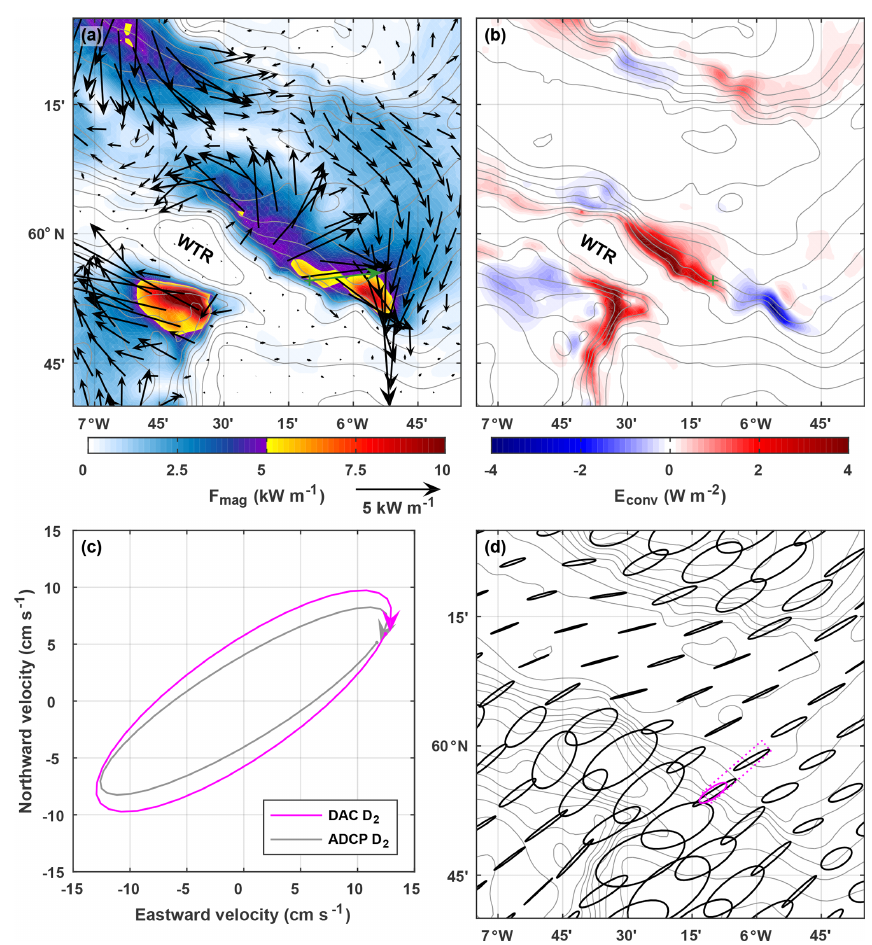
Figure 5. (a) Depth-integrated M 2 internal tide energy flux from the regional tide model described by Hall et al. (2011). Vectors are plotted every five grid points (5km) in each direction. The underlying colour is the energy flux magnitude. The green vector is the depth-integrated D 2 internal tide energy flux observed at the green cross. (b) Barotropic-to-baroclinic M 2 energy conversion from the model. (c) D 2 surface ellipses calculated from glider-inferred DAC velocity (magenta) and ADCP-measured barotropic velocity (grey). (d) M 2 surface ellipses, every 10 grid points (10km) in each direction, from the model. The magenta ellipse is calculated from DAC velocity and is representative of the area that contains all the dives deeper than 500m (delineated by the dotted magenta line). The bathymetry contour interval is 100m.